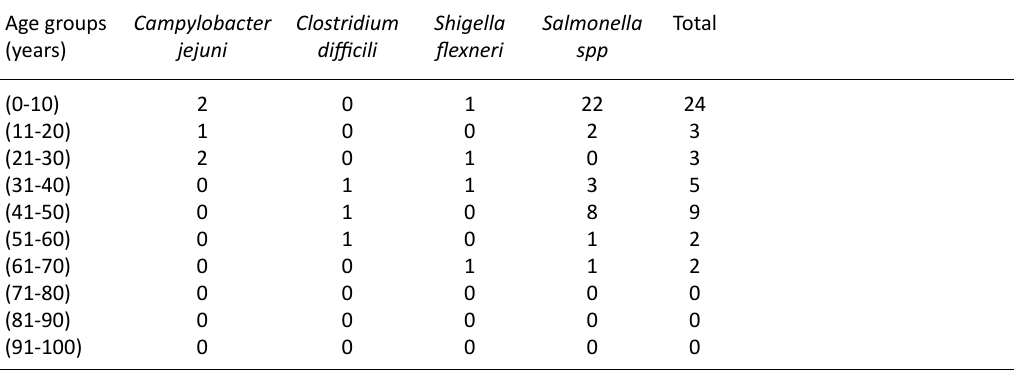
Table 3. Distribution of enteric bacteria in association with age groups Age groups